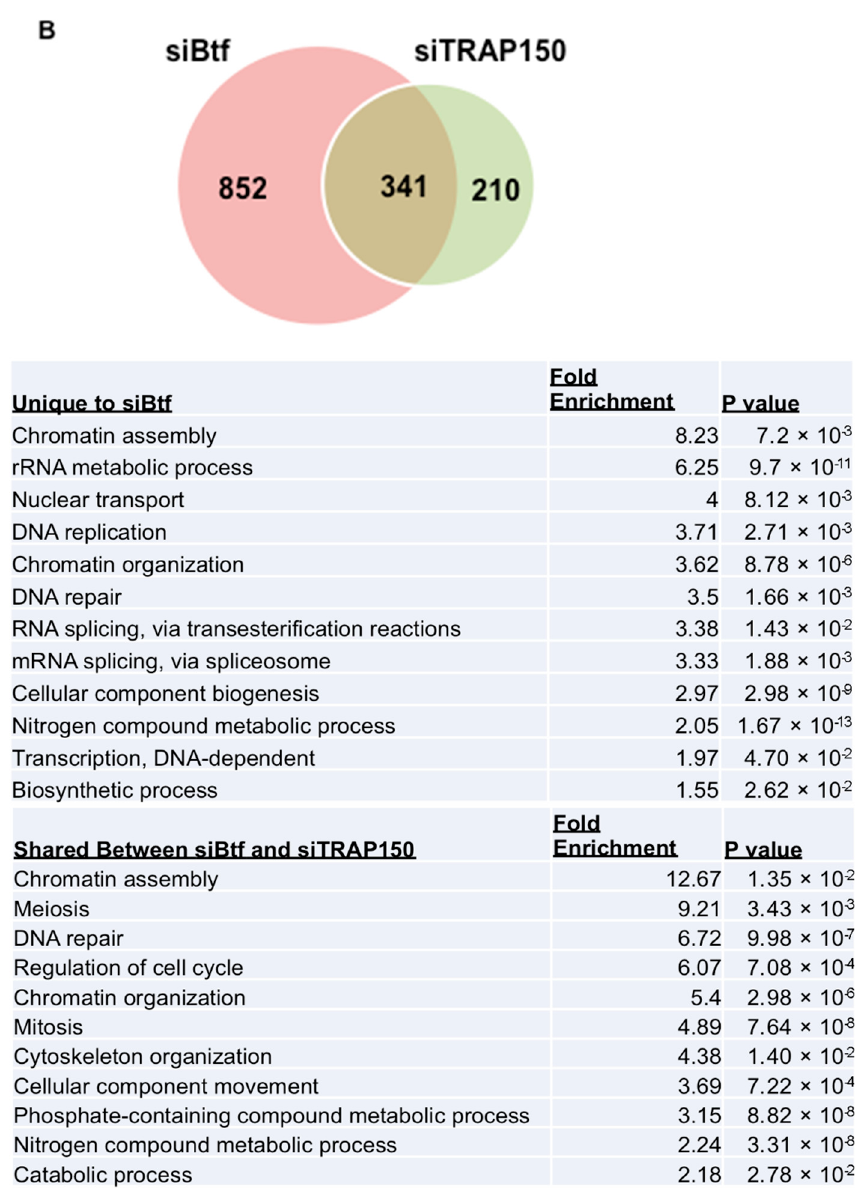
Figure 3. Pathways affected in Btf and TRAP150 depleted cells. ( A ) Overlapping pathways and total transcript and splicing changes between Btf- and TRAP150-depleted samples. Unique to Btf were fluoropyrimidine activity (7%), benzo(a)pyrene metabolism (4%), and nucleotide metabolism (4%). Unique to TRAP150 were the alpha 6 beta 4 signaling pathway (5%) and the mitochondrial long chain fatty acid beta oxidation pathway (4%); ( B ) Btf and TRAP150 share transcriptional effects on a subset of genes. Differentially expressed genes (Benjamini-Hochberg -adjusted p -values < 0.05, fold change > 2) for siBtf and siTRAP150 were compared. A set of 341 shared genes were differentially expressed in response to siBtf or siTRAP150. There were 852 differentially expressed genes unique to siBtf, but only 210 in siTRAP150. These gene lists were submitted for gene ontology analysis. The gene ontology analysis was performed using the PANTHER Overrepresentation Test (Ref. [20]) (release 20170413) using all Homo sapiens genes as the reference list and the PANTHER GO-Slim biological process as the annotation data set. The genes uniquely regulated by siBtf were enriched for genes involved in chromatin assembly, RNA splicing, and other processes, while the list of genes unique to siTRAP150 has no significantly over-represented biological processes. However, the genes regulated by both Btf and TRAP150 were involved in chromatin assembly, meiosis, DNA repair, and other processes as indicated.